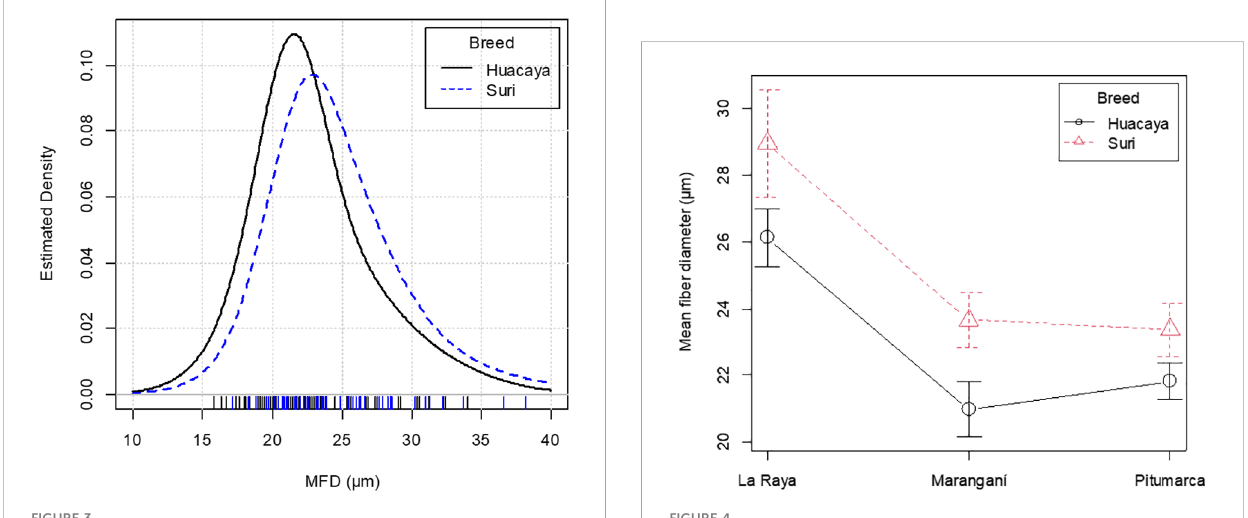
FIGURE 4 Comparison of alpaca mean fi ber diameter by location and breed. Mean ± standard error of mean fi ber